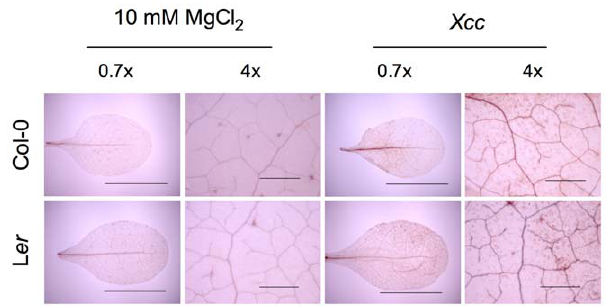
Figure 2. Xcc induces ROS accumulation in Arabidopsis. Four- week-old Arabidopsis plants were syringe-infiltrated with Xcc (OD 600 =0.02) or mock control (10 mM MgCl 2 ). At 4 hpi, infiltrated leaves were excised and stained with DAB (3,3 9 -diaminobenzidine tetrahydrochloride). The presence of ROS (mainly hydrogen peroxide) caused polymerization of DAB, yielding a reddish-brown color. Tissue was examined under a Leica MEIJI scope. Representative images shown here came from 24 leaves from 12 independent plants. Bars represent